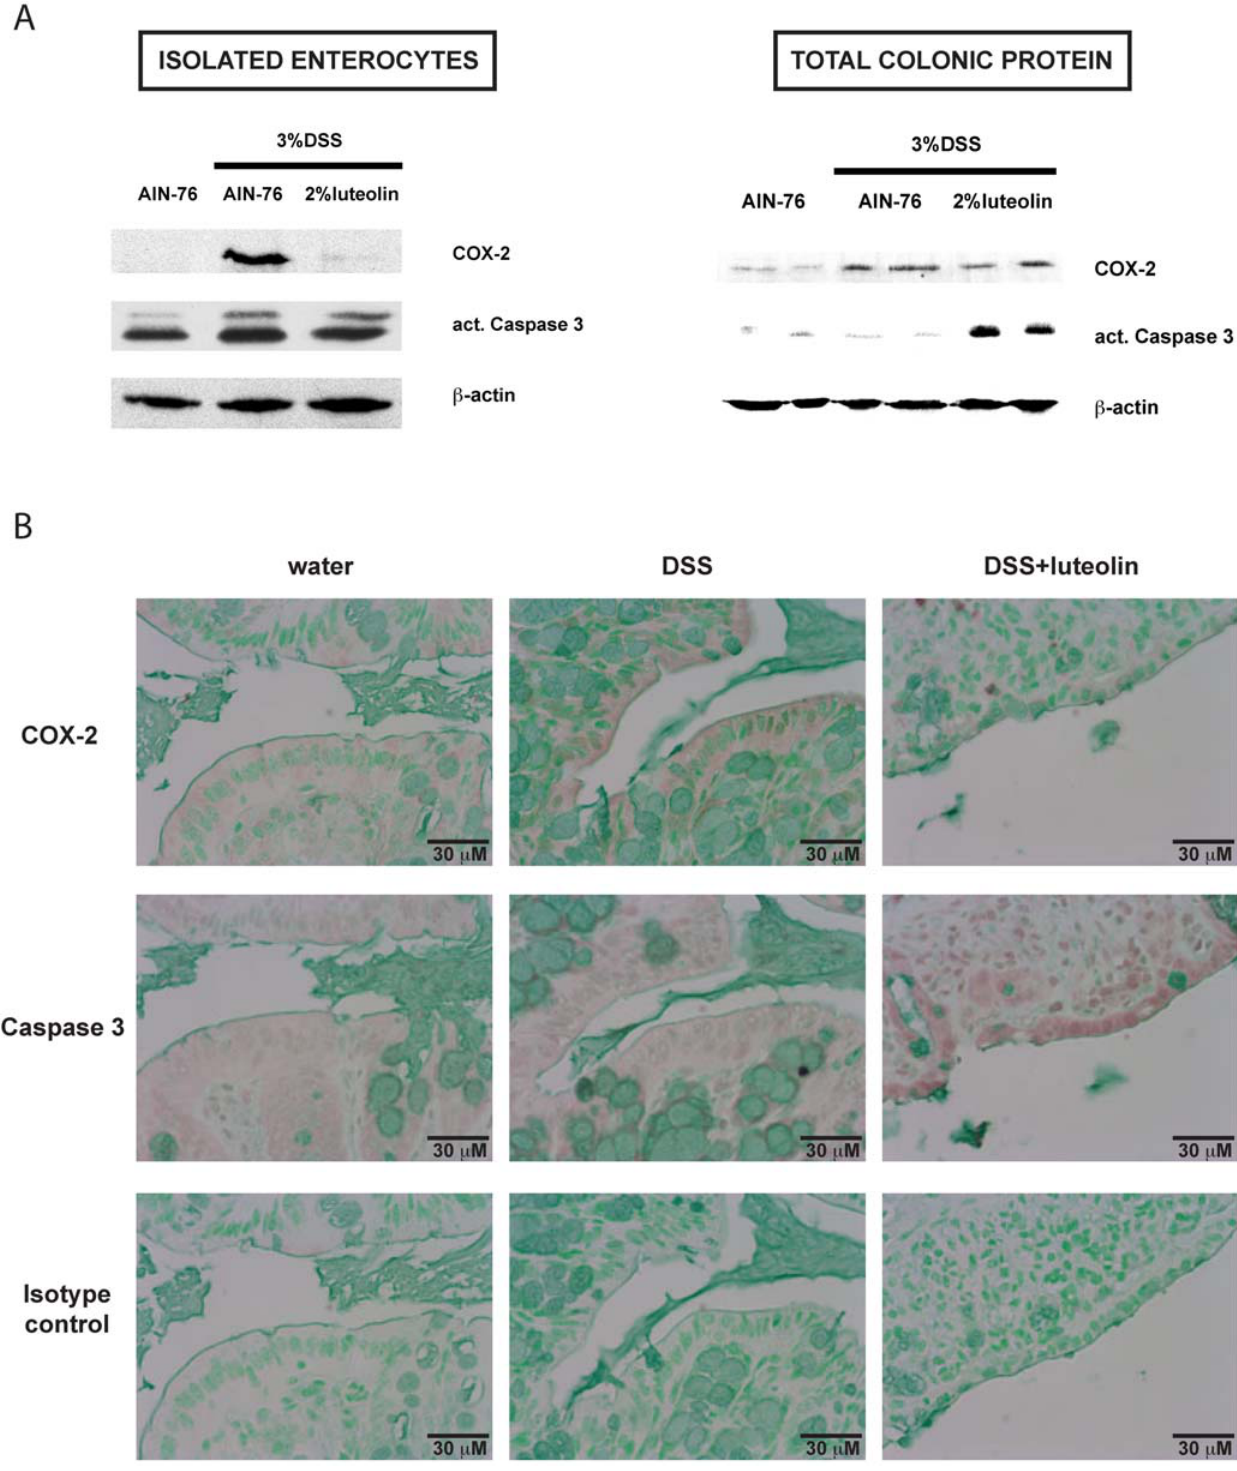
Figure 3. 2% luteolin enhances caspase 3 activation and suppresses COX-2 protein accumulation in enterocytes after DSS exposure. NF- k B EGFP mice (n=7/group) were sacrificed after 2 days of 3% DSS exposure and protein (20 m g) from primary enterocytes (A, left) and total colonic lysates (A, right) were subjected to SDS-PAGE. COX-2 expression and caspase 3 processing were evaluated using specific antibodies against cleaved caspase 3 and COX-2, respectively, and immunoreactive proteins were detected using the enhanced chemiluminescence (ECL) technique (A). NF- k B EGFP mice (n=7/group) were sacrificed after 2 days of 3% DSS exposure, and cellular localization of COX-2 proteins (top panel) and caspase 3 processing (middle panel) were analyzed in the colon using IHC. Sections were counterstained with a mixture of methyl-green and alcian-blue. An isotype- control antibody was used to determine staining specificity on the same colonic section (lower panel). Representative results out of 2 different sections per each animal (n=14/group) are shown (B).